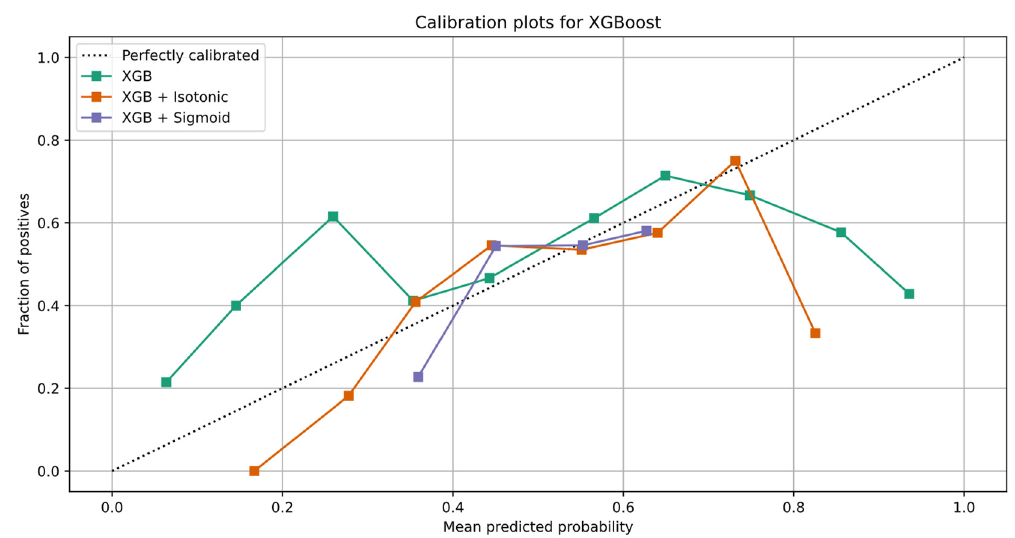
Figure 10. Calibration plot of XG Boost classifier for class 1.